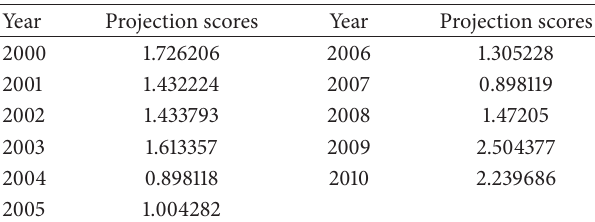
Table 2: Projection scores from 2000 to 2010 of Qilin.